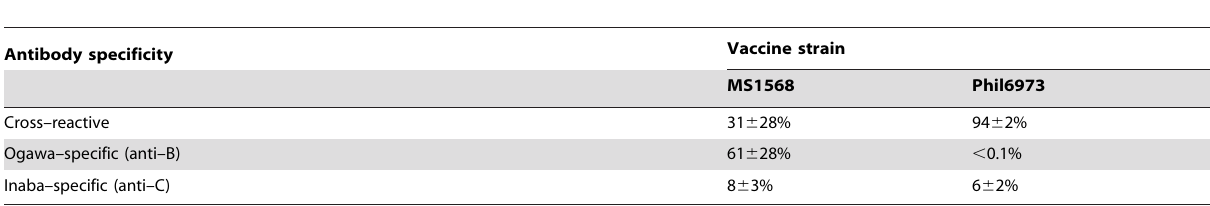
Table 1. Percentages of cross–reactive, Ogawa–specific and Inaba specific antibodies in immune sera from CD1 mice after intraperitoneal vaccination with formalin–killed bacteria of strains MS1568 and